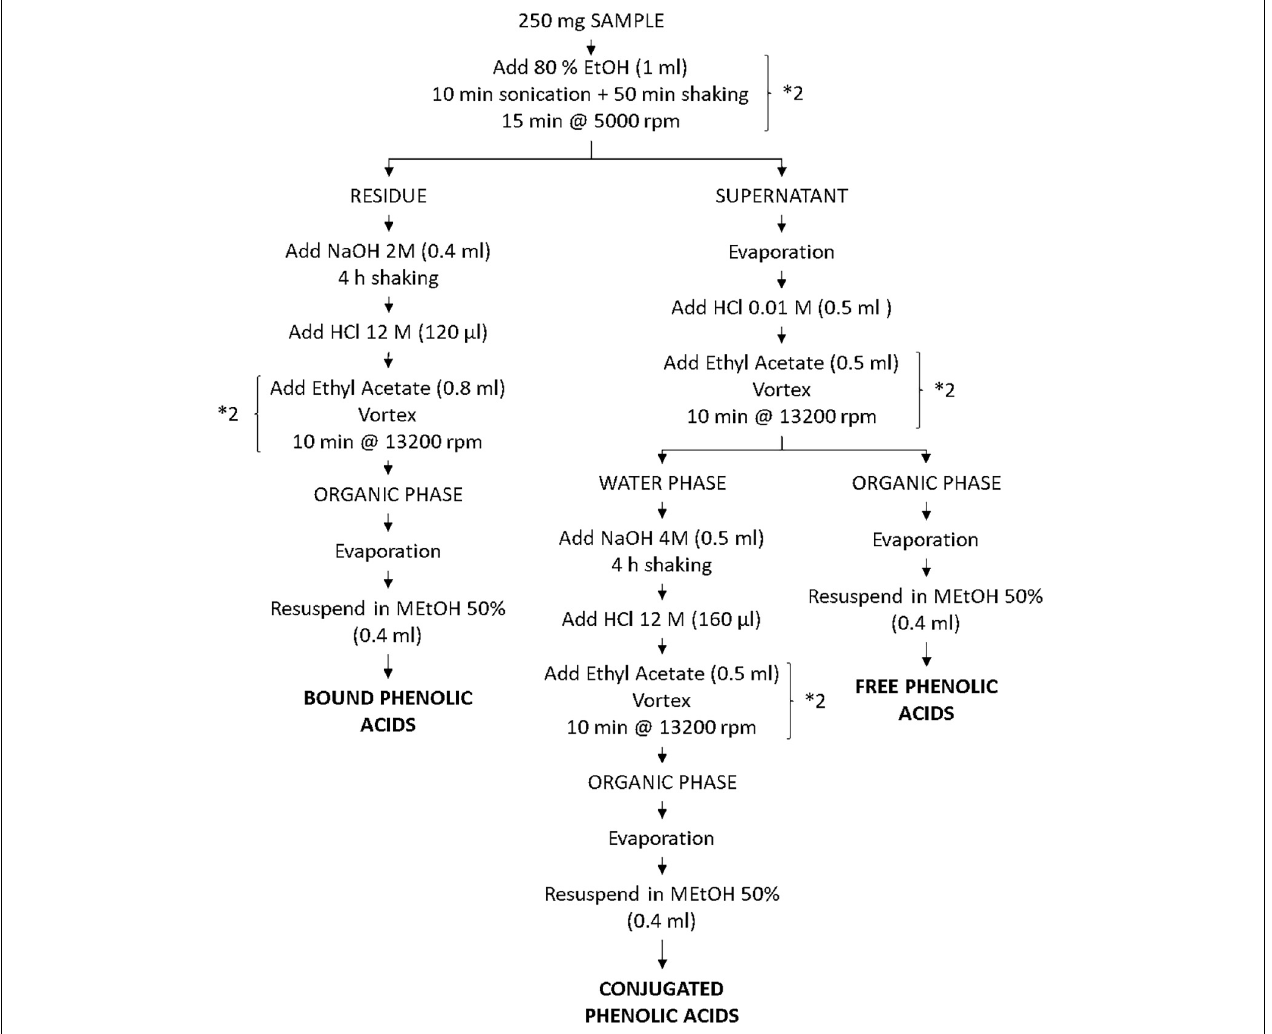
FIGURE 1 | Scheme of the adapted method for the extraction of the free, conjugated, and bound phenolic from